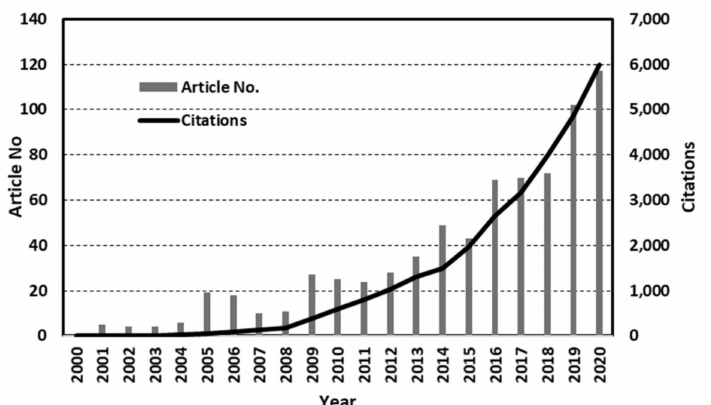
Figure 3. Number of articles (Article No.) on water and wastewater treatment and related citations regarding PMRs from the year 2000 to 2020 documented in the Scopus database (keywords: “photo- catalytic membrane reactor” or “membrane photoreactor” or “photocatalytic membrane” and “water treatment” or “wastewater